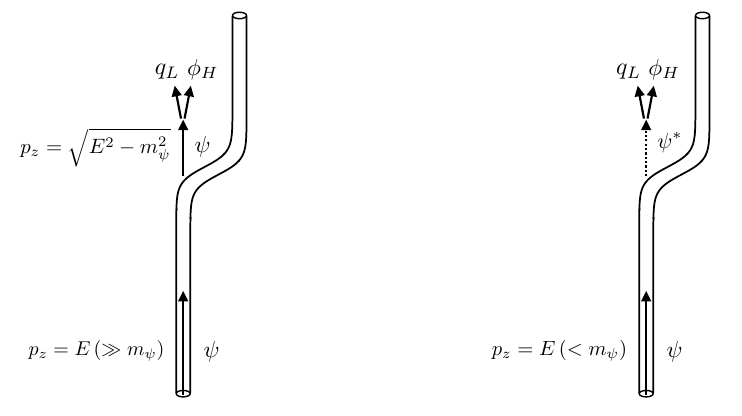
Figure 1 . Schematic pictures of the decay of the fermion zero mode in the curved string. The (cid:16) (cid:17) curvature radius of the curve is O m − 1 . For the zero mode with | p z | (cid:29) m ψ , it escapes from the φ string at the curve and decays via the decay operator. For the zero mode with | p z | < m ψ , it decays through the quantum